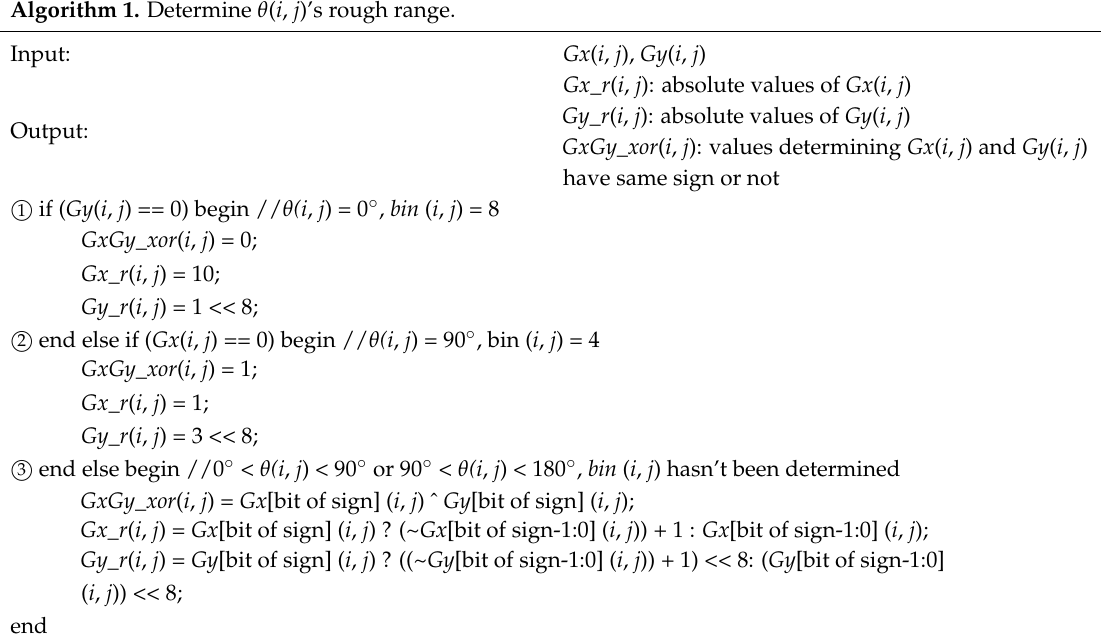
Algorithm 1. Determine θ ( i , j )’s rough range.